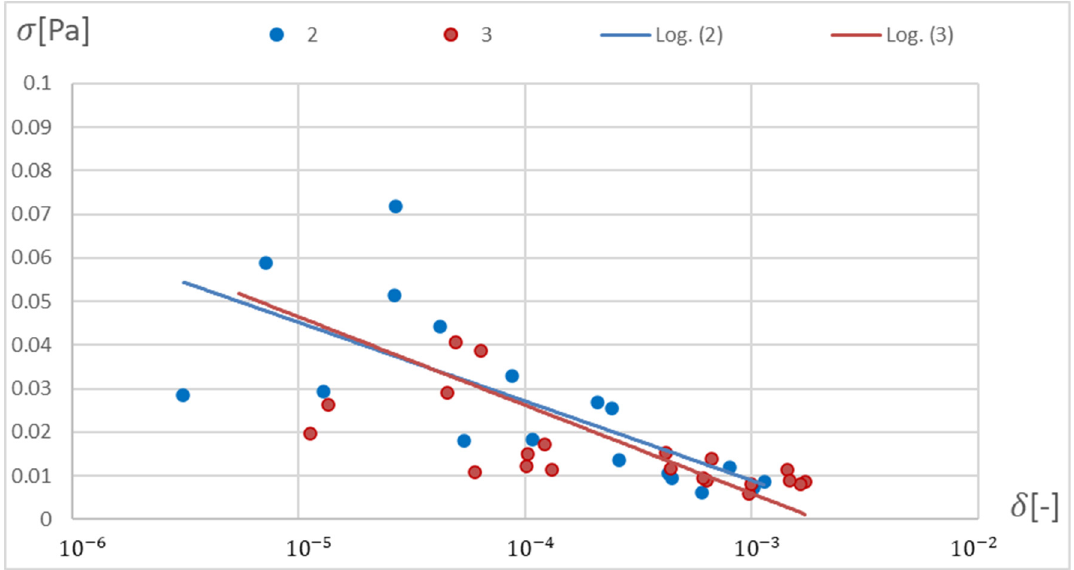
Figure 21. Pareto front depending on the number of neurons in the hidden layer with trend lines marked. Network trained with the RPROP method.